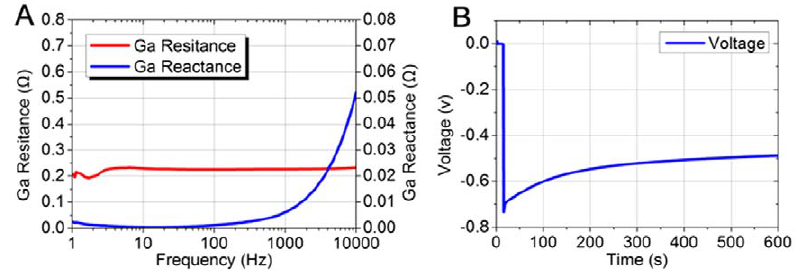
Figure 3. The impedance and polarization voltage of the Ga-based liquid metal ink. (A) The resistance and reactance curve from 1 Hz to 10 kHz for the liquid metal in a 40 cm long tube with a diameter of 1 mm; (B) The polarization voltage curve when the liquid metal contacts with physiological saline.